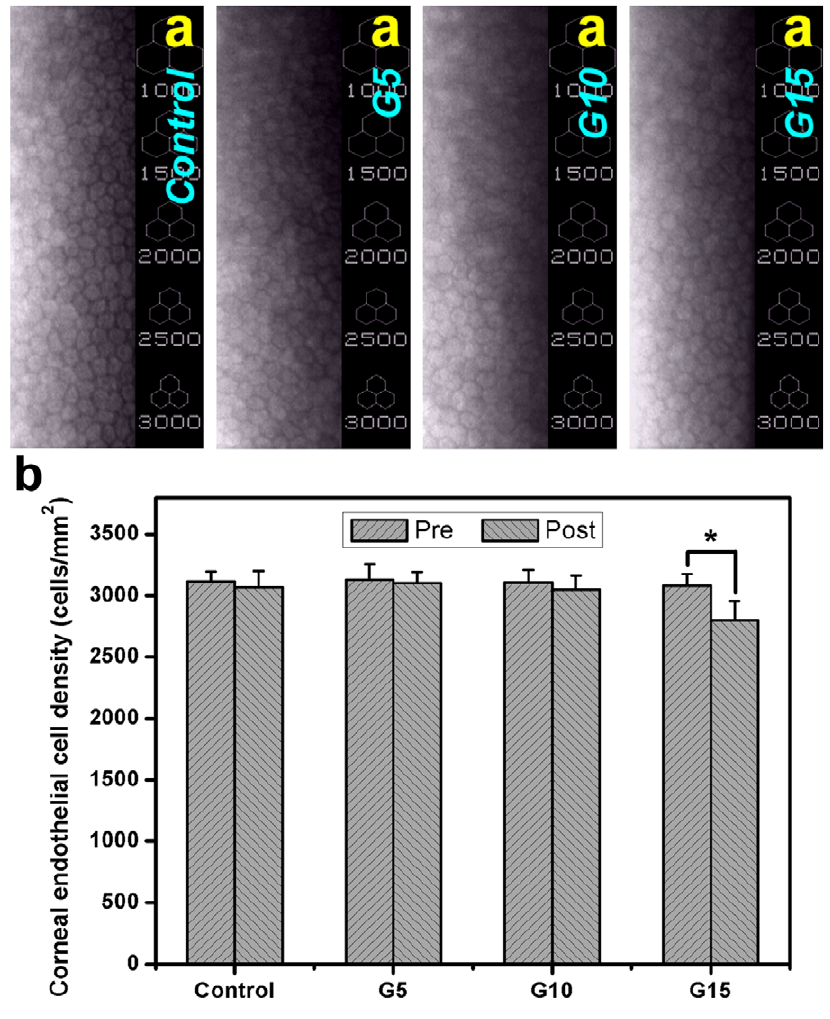
Figure 9. In vivo studies. Specular microscopy measurements of rabbit corneal endothelium 3 days after surgical insertion of various gelatin implants in the ocular anterior chamber. (a) Typical images; (b) graph of corneal endothelial cell count. An asterisk indicates statistically significant differences (* P , 0.05; n =6) between the preoperative (Pre) and postoperative (Post) cell density for each type of gelatin disc. The rabbits received no implant (only corneal/limbal incision) and served as a control (sham-operated)